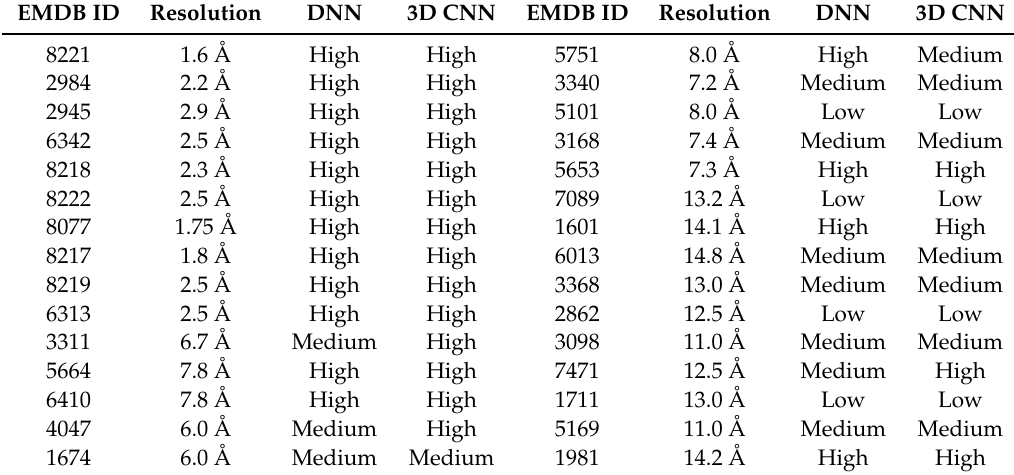
Table 2. Classification results of the 30 experimental cryo-electron microscopy (cryo-EM) density maps with dense artificial neural network (DNN) and convolutional neural network (3D CNN).